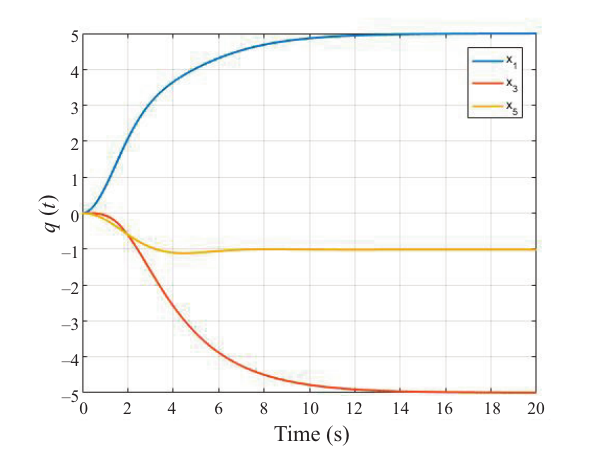
Figure 1. Configuration q ( t ) during stabilization maneuver. Fig. Fig. 7. Displacement mode shapes of fixed-fixed bar.